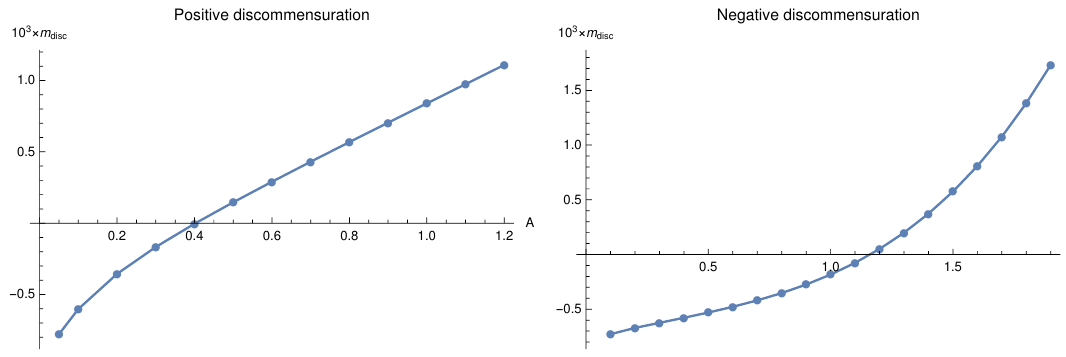
Figure 9 . Mass of an isolated discommensuration , depending on the amplitude of the lattice. At small amplitude the mass is negative signaling that the commensurate state is unstable. At large amplitude discommensurations become massive and the pure commensurate state